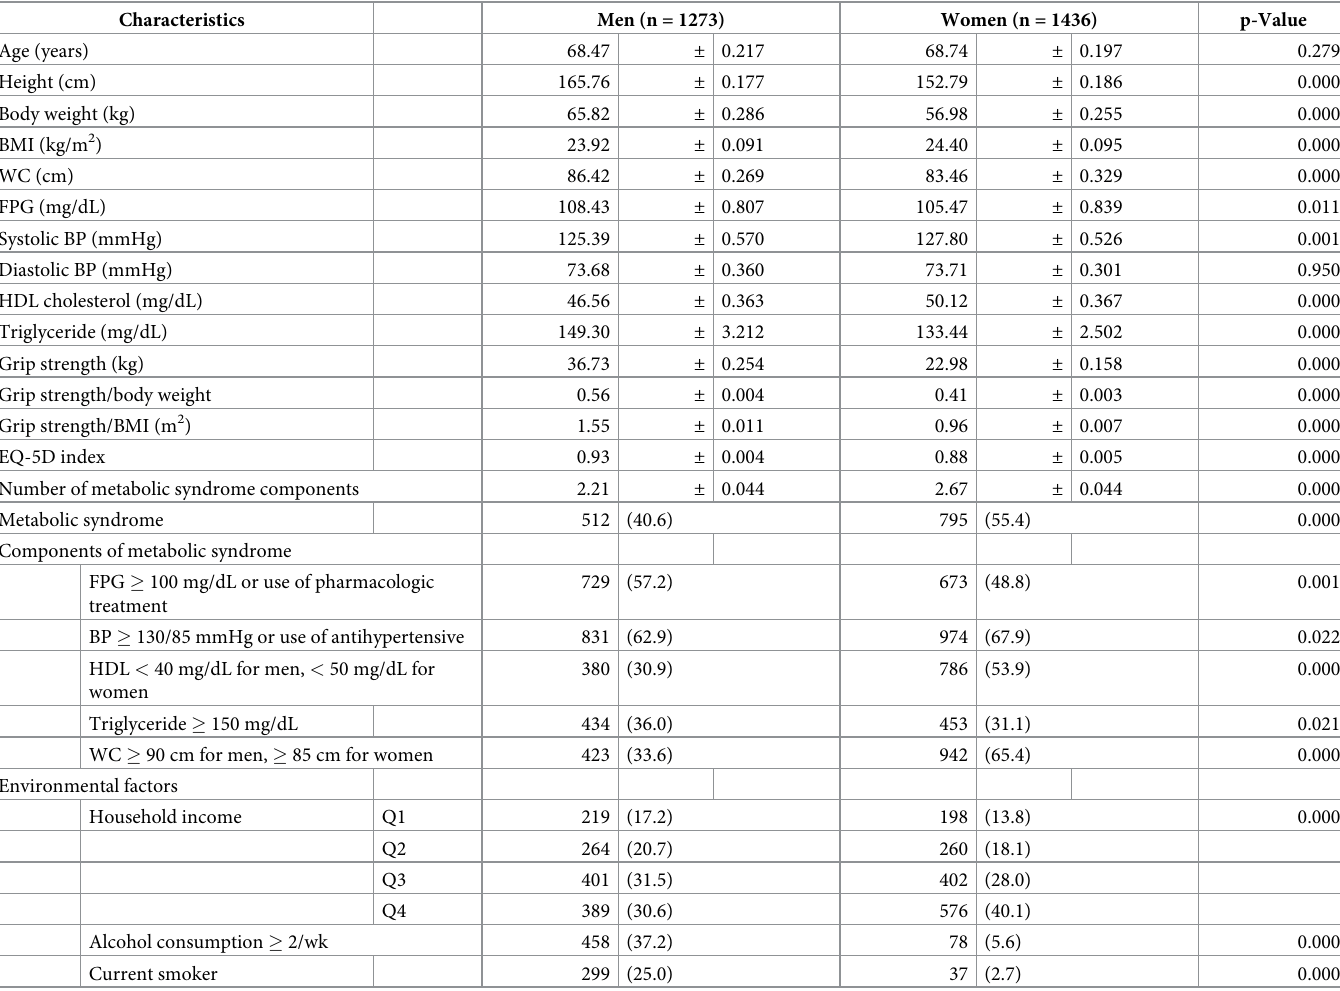
Table 1. Basic characteristics of men and women aged 60 years or older in the Korean National Health and Nutrition Examination Survey 2014–2015 (N = 2709).